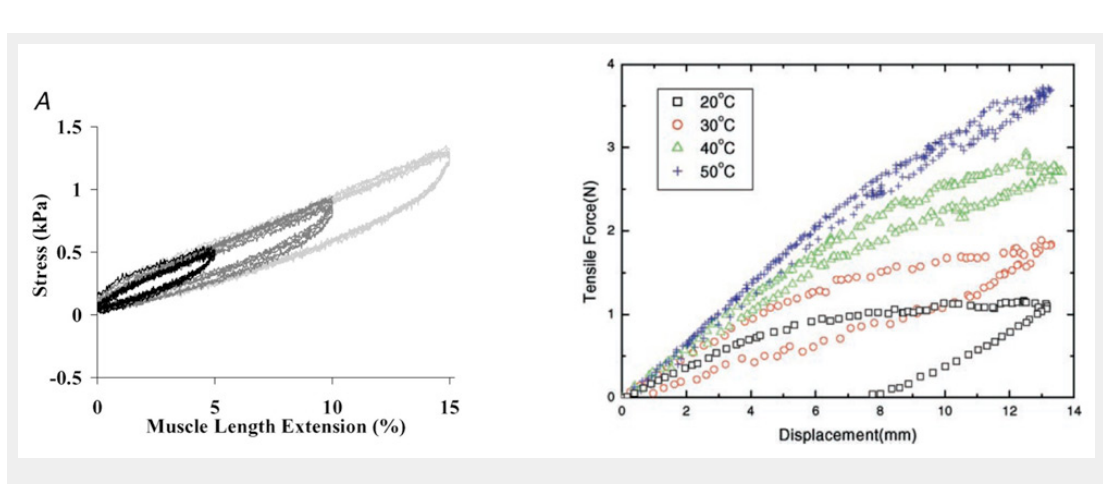
The above curves illustrate the extension relationship of a muscle that is stretched (left) and an SMA spring actuator (right) at different temperatures. The idea in this comparison is to identify a hysteresis loop in both cases. Left: typical stress–muscle length extension